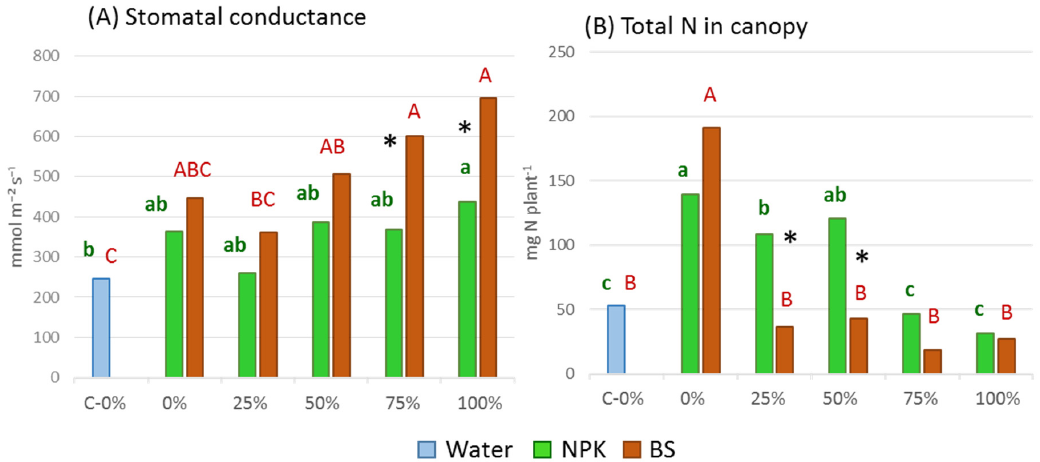
Figure 3. Dickson quality index ( A ) and root mass ratio ( B ) of chestnut plants cultivated with the different substrate mixtures (compost: 0%, 25%, 50%, 75% and 100%) supplied with NPK (green bars) or BS (brown bars). Blue bars represent control substrate of 0% supplied only with water. Different letters indicate significant differences ( p < 0.05; n = 6) between each substrate mixture (green lowercase letters for NPK and brown uppercase letters for BS). Asterisk means significant differences using t -tests between NPK and BS within each substrate mixture.